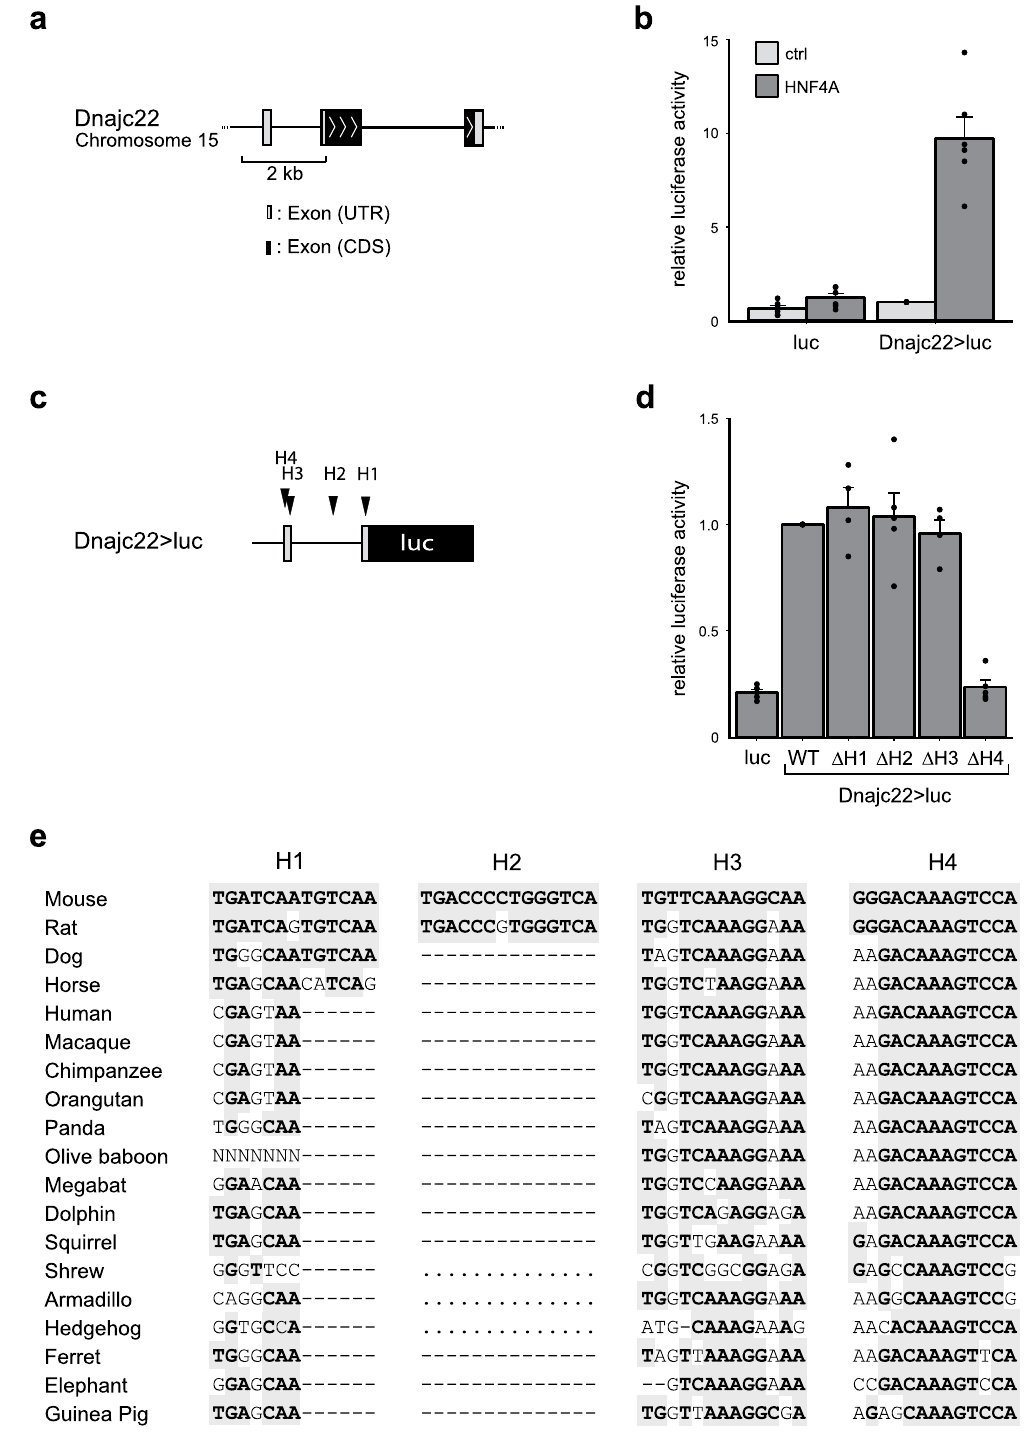
Figure 4. Identification of a functional Hnf4a binding site for murine Dnajc22. ( a ) Schematic presentation of the genomic locus of murine Dnajc22 indicating the 2 kb fragment cloned upstream of luciferase to test for responsiveness to heterologous HNF4A expression. ( b ) Heterologous expression of human HNF4A in murine M-1 cells increases luciferase activity of a construct driven by the 2 kb promoter fragment of murine Dnajc22 (normalized to Dnajc22 > luc control). Significance testing was performed using a one-sided paired t-test. ( c ) Predicted Hnf4a binding sites in the Dnajc22 > luc construct, denoted H1-4. ( d ) Analysis of single mutants of the four predicted Hnf4a binding sites ( ∆ H1-4) show significantly reduced luciferase activity compared to the WT fragment after heterologous HNF4A expression only for ∆ H4 (normalized to the WT construct). Significance testing was performed using a one-sided paired t-test. ( e ) Genomic alignment of the four identified potential HNF4A binding sequences in the Dnajc22 locus in 19 species including mouse, rat, and human shows greatest conservation for